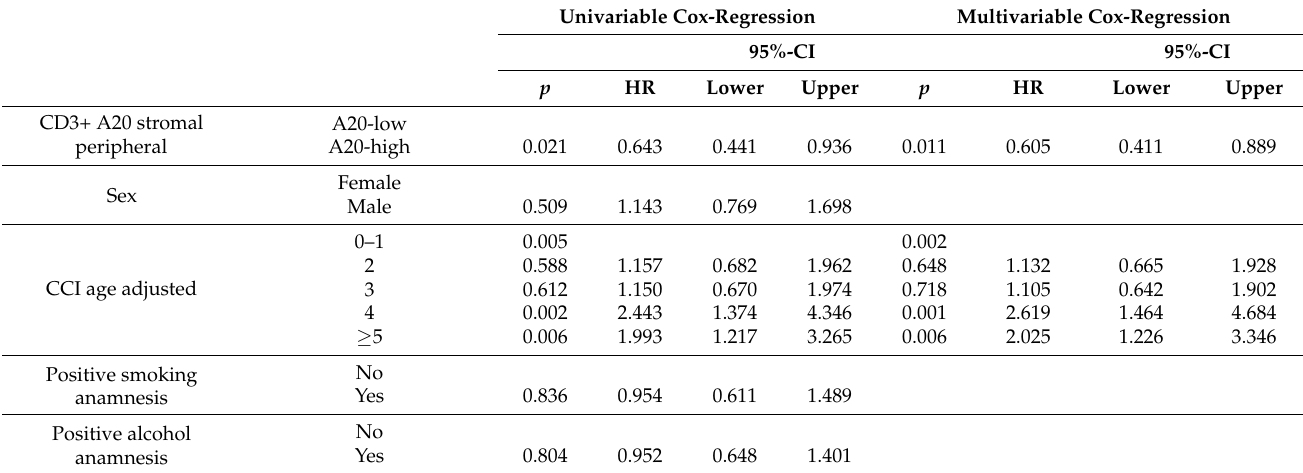
Table 3. Results from univariable and multivariable Cox-regression analyses for recurrence-free survival in patients according to high and low A20 expression, respectively (cut-off: 2.5 (median value)) within stromal CD3+ T cells in the peripheral tumor area. Multivariable analysis adjusted for age-adjusted Charlson comorbidity score, UICC stage, vein invasion and adjuvant/additive radiotherapy, which proved to have p < 0.100 in univariable analysis. Tumor size, cervical node status and extranodal spread were dismissed in favor of UICC